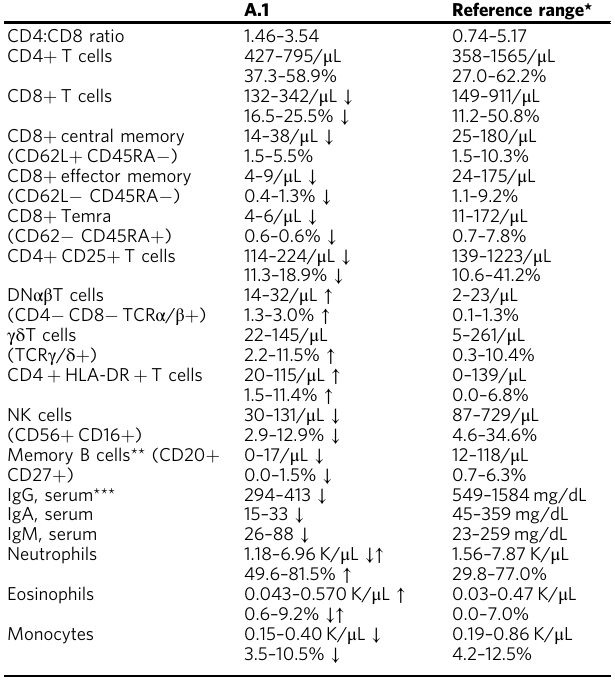
Aminimumofthreetestsfromindependentblood drawsareincludedforeachrow.Percentages indicate % of lymphocytes for lymphocyte populations and % of leukocytes for non-lymphocyte populations. *Listed ranges re fl ect the aggregate of ranges used by the NIH Clinical Center for each age (as established at the time of testing) at which blood draws from patient A.1 are included. In some instances, lab values fall outside the corresponding age-matched reference range but do not fall outside the aggregate range. **Prior to receiving rituximab. ***Prior to receiving